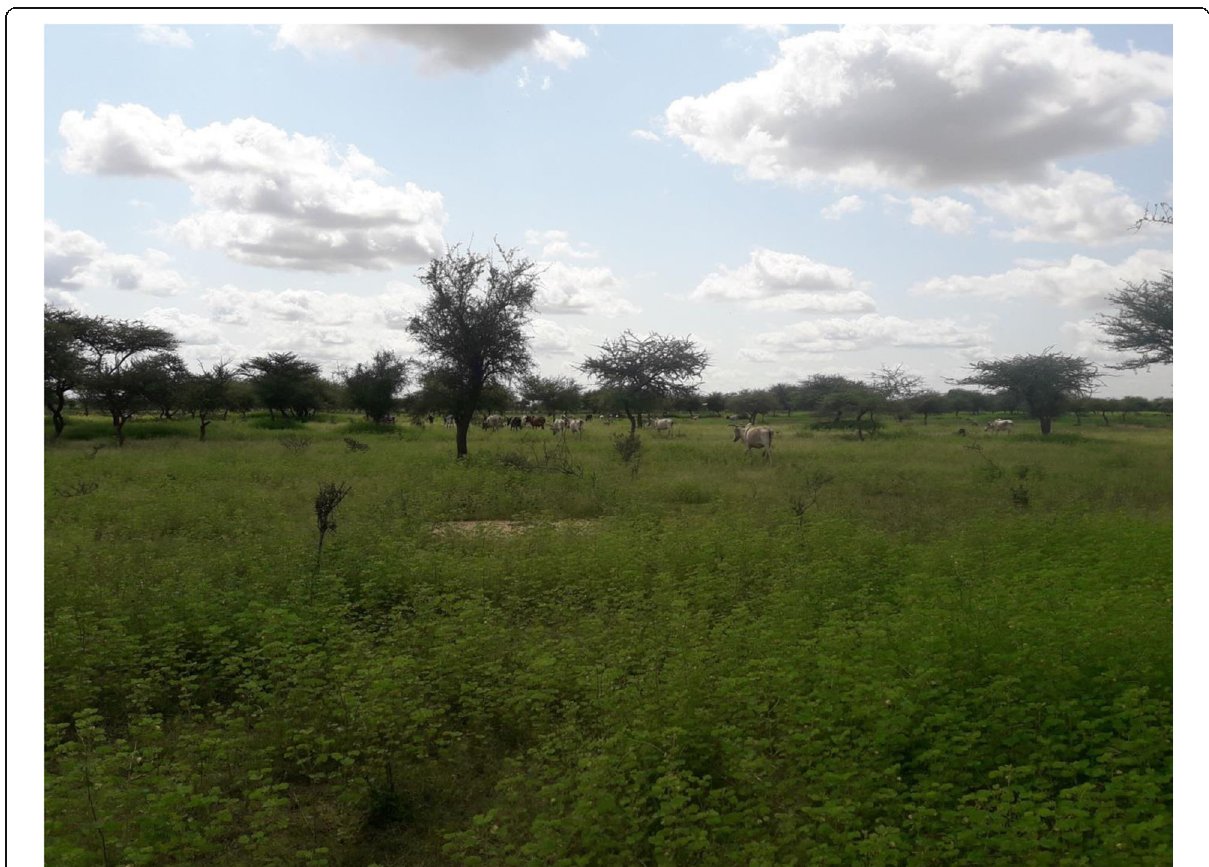
Fig. 3 Stands of Senna obtusifolia in the pastoral zone of Ceekol